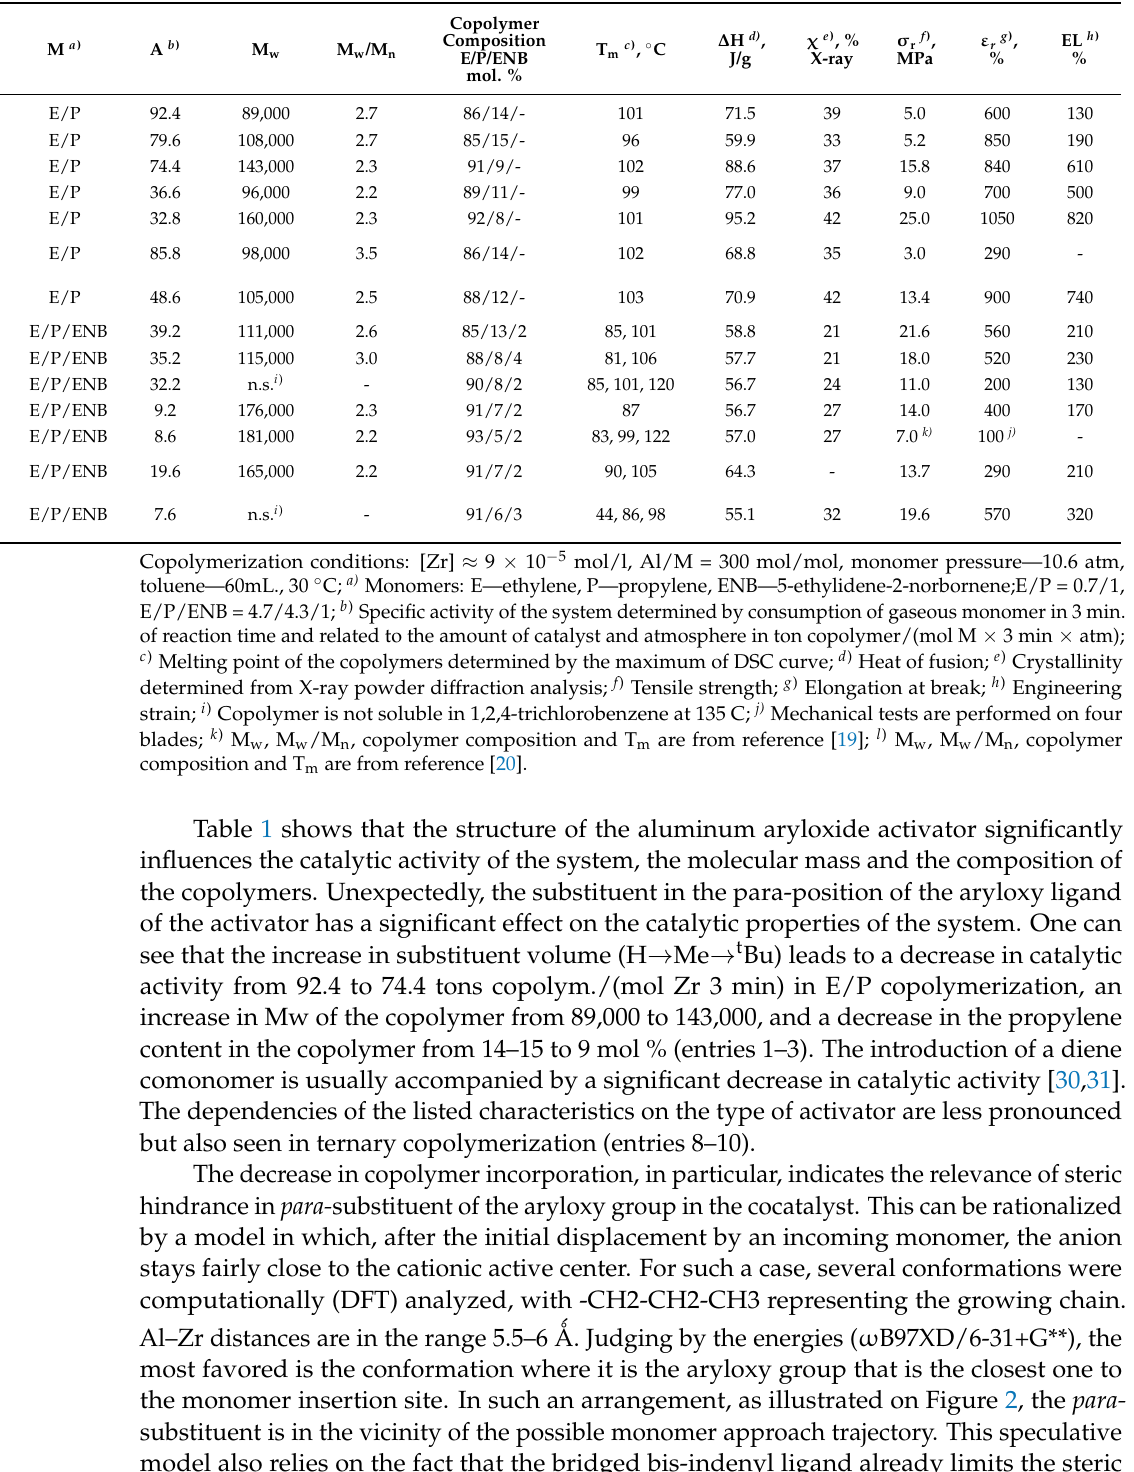
Table 1. Copolymerization of ethylene with propylene and terpolymerization of ethylene, propylene and 5-ethylidene-2-norbornene on rac -Et(2-MeInd) 2 ZrMe 2 /isobutylaluminum aryloxide, copolymer